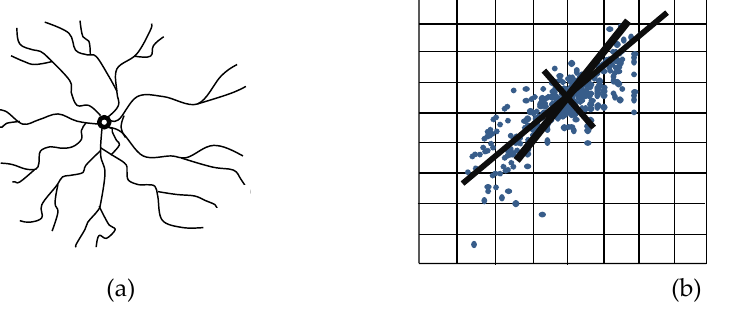
Figure 1. Multiple radial hydraulic fractures near a vertical wellbore: ( a ) Chen et al. [9]; Germanovich et al. [23] and ( b ) Craig and Blasingame [24].